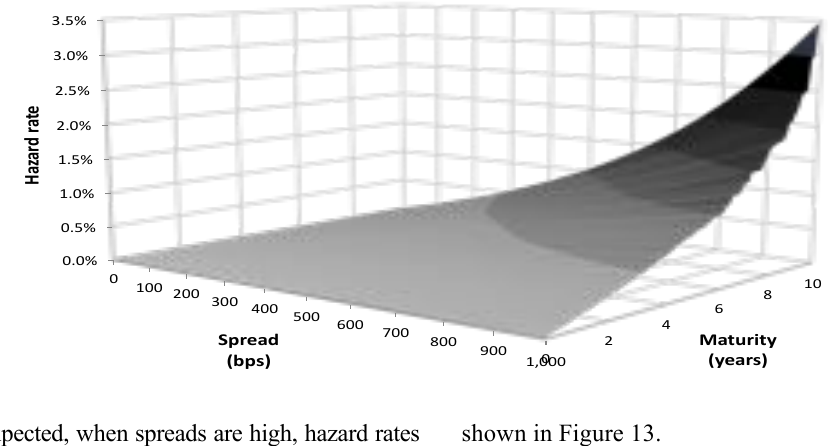
Relationship between spread level maturity of underlying derivative and hazard rates. As before, the outcome depends heavily on the absolute spread level